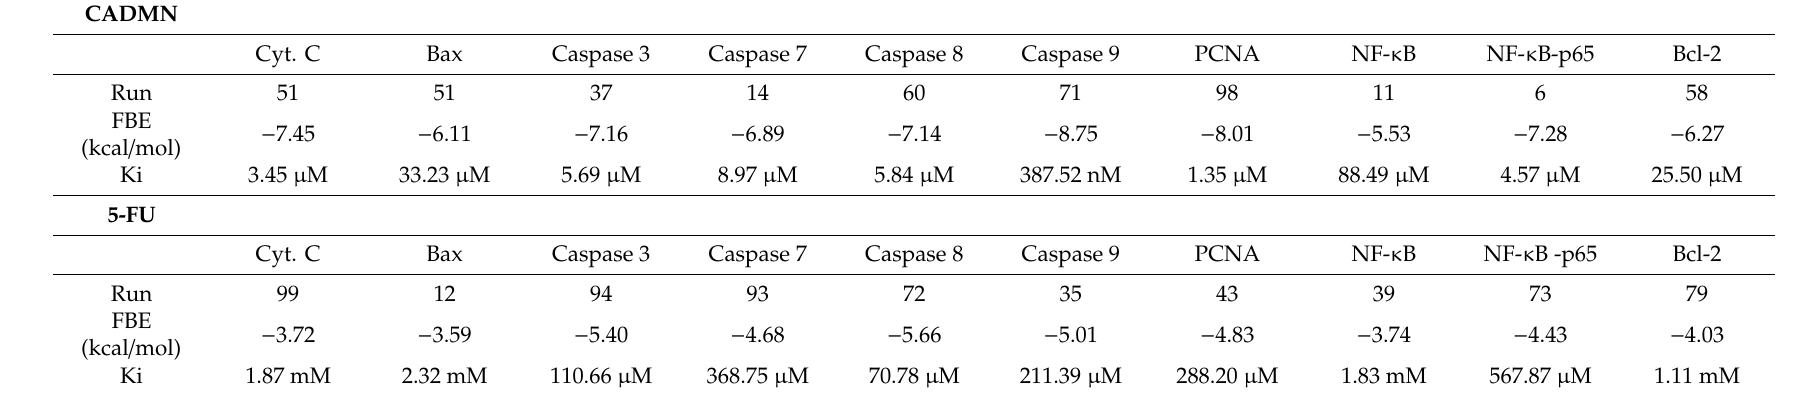
Table 2. Free binding energy of cardamonin and 5-FU after interaction with di ff erent